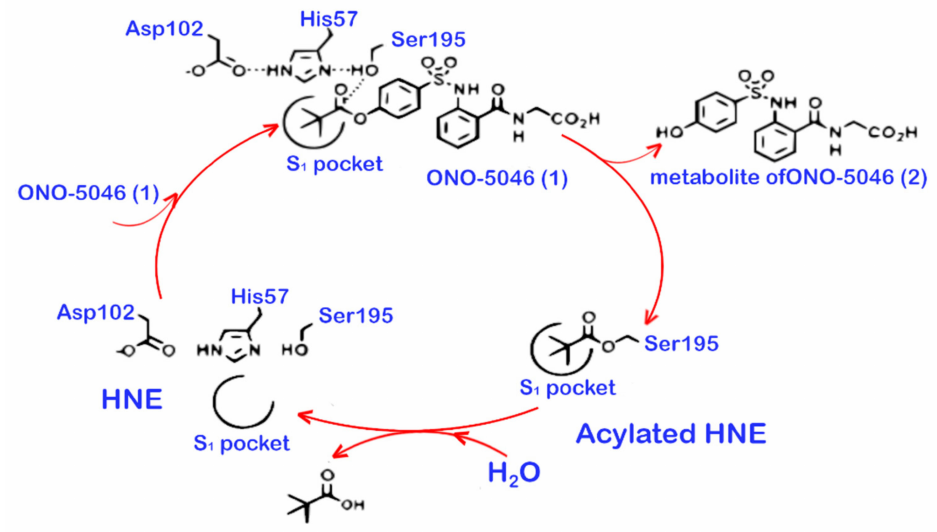
Figure 2. The proposed mechanism of NE inhibition by